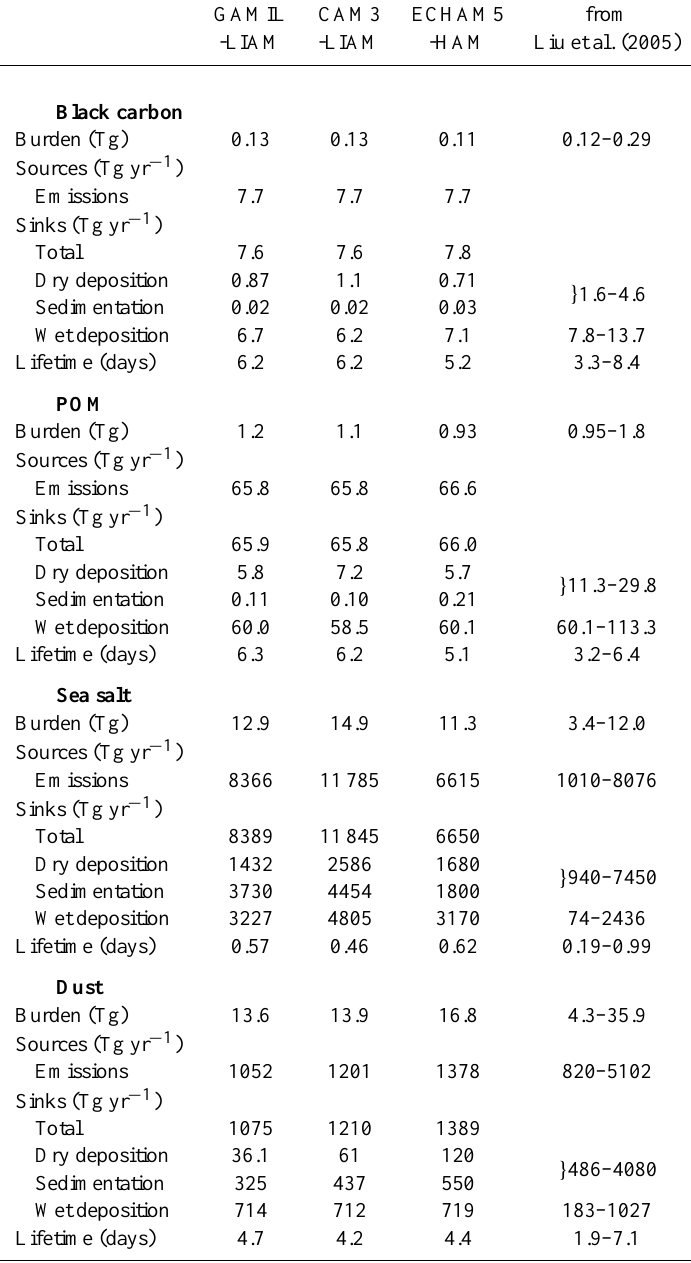
Table 6. Annual mean global BC, POM, SS, DU budgets obtained in this study and from the literature. GAMIL CAM3 ECHAM5 from -LIAM